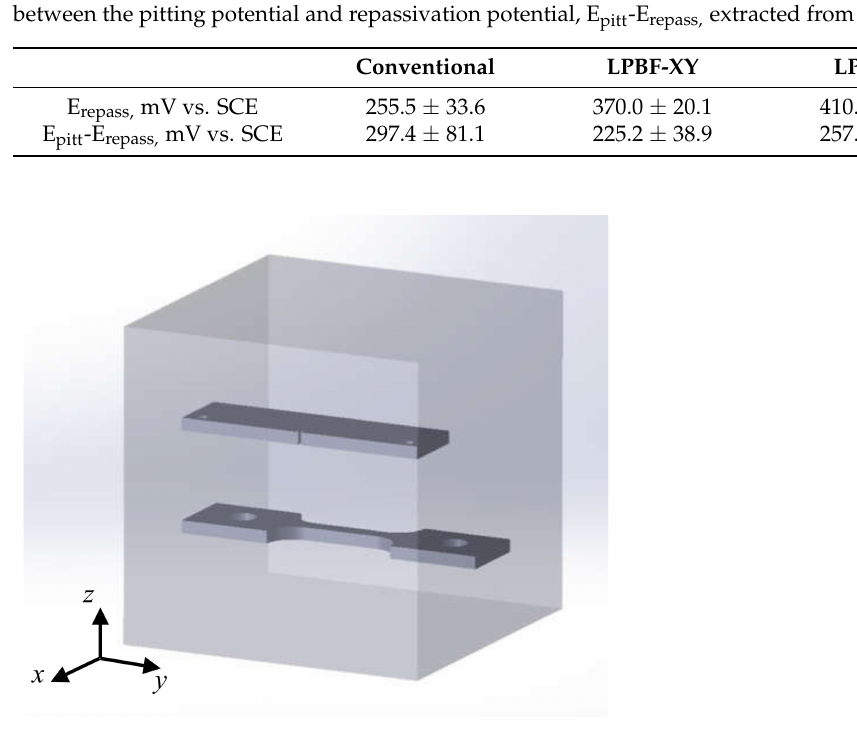
Figure 3. Sample orientation and its relationship with the